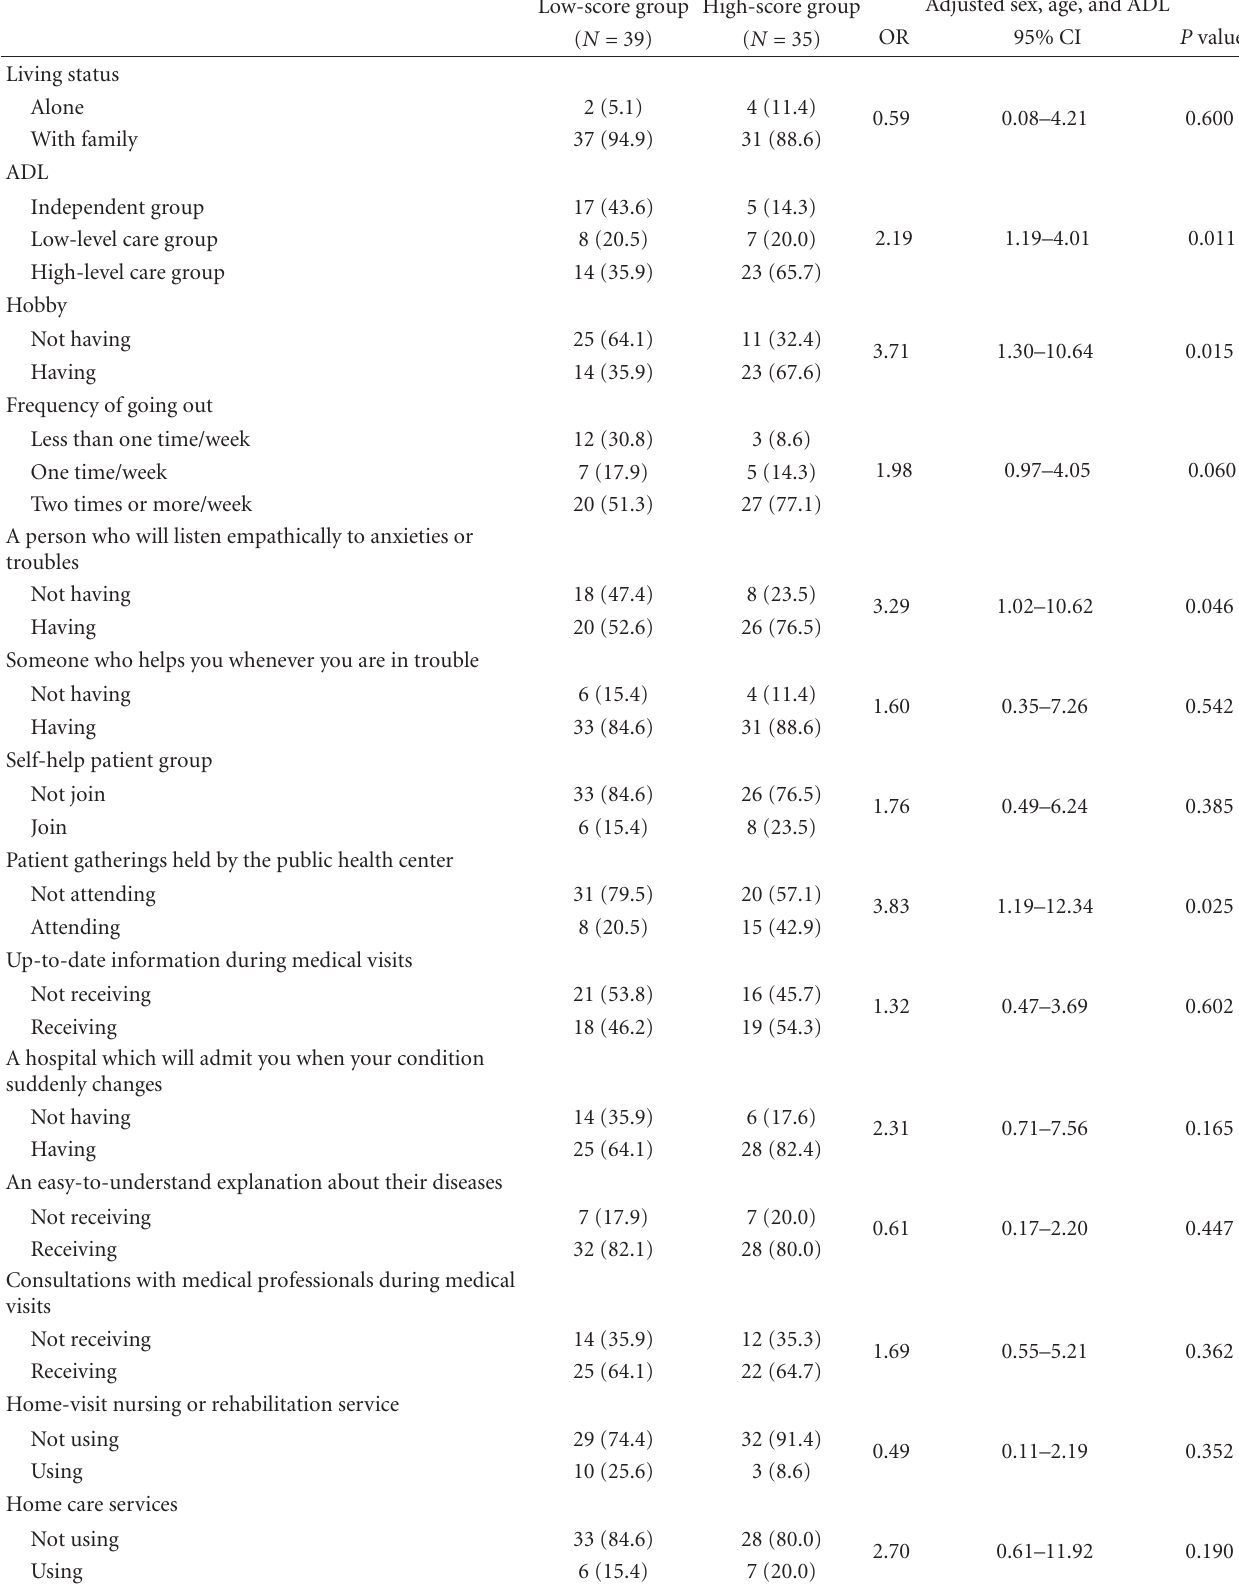
Table 2: Factors related to the total WHOQOL score (Low-score and high-score